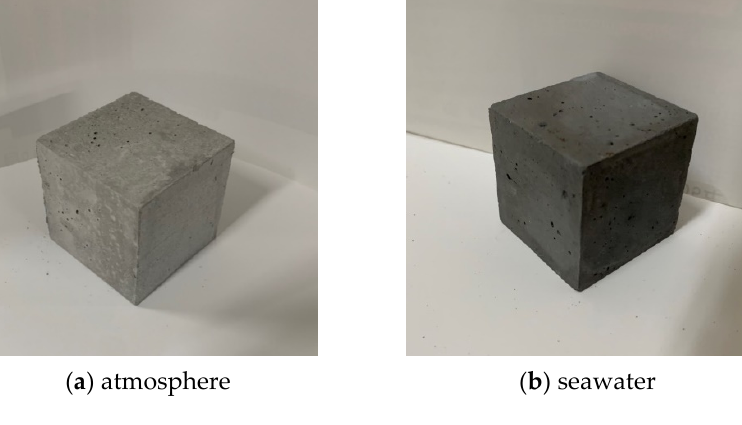
Figure 7. Appearance of the three immersed and exposed specimens.